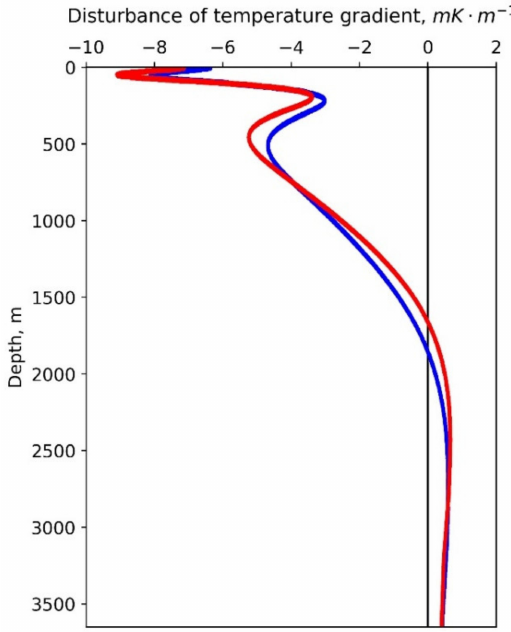
Figure 11. The disturbance of the temperature gradient along the well caused by the paleoclimate. The red line represents the results of assessing the effect of the paleoclimate considering an average rock thermal diffusivity of 10 − 6 m − 2 · s − 1 , and the blue line represents the results of assessing the effect of the paleoclimate considering an average rock thermal diffusivity of 1.2 · 10 − 6 m − 2 · s − 1